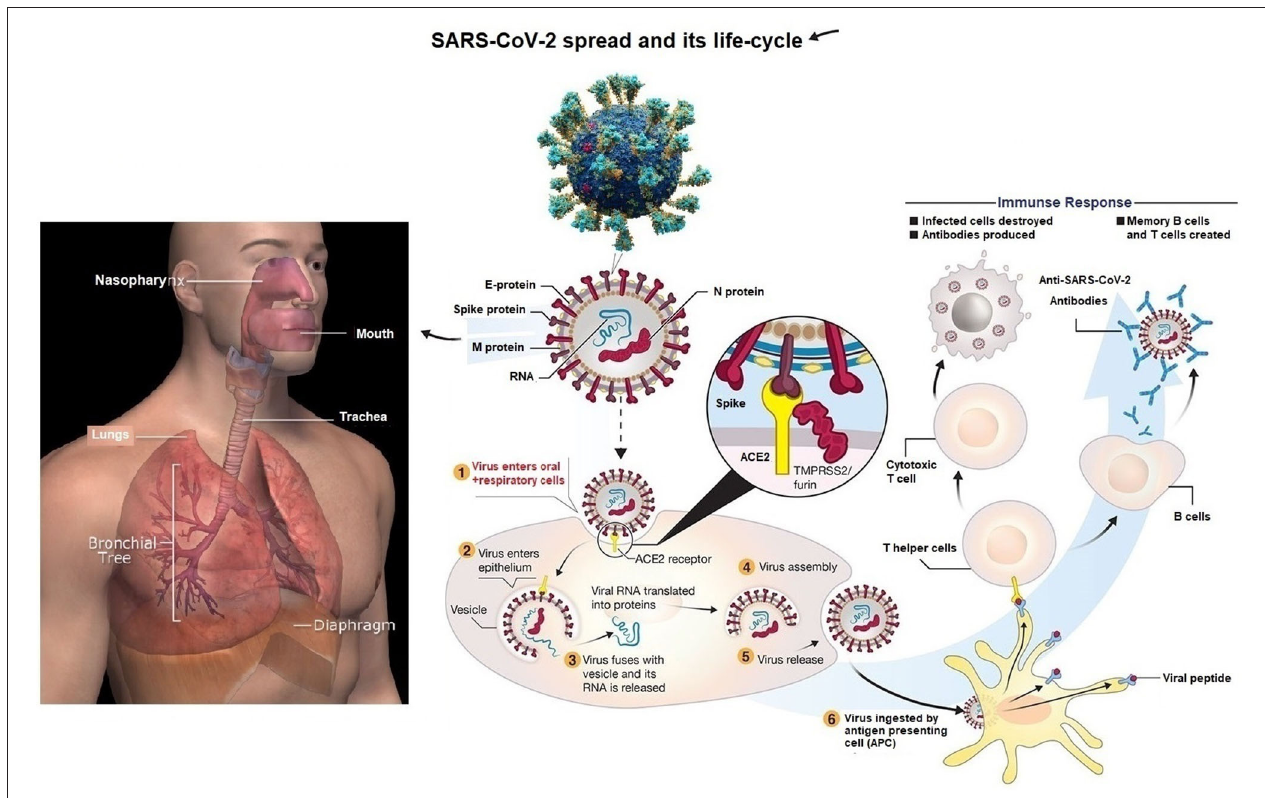
TABLE 1 | Global total cases, recoveries.